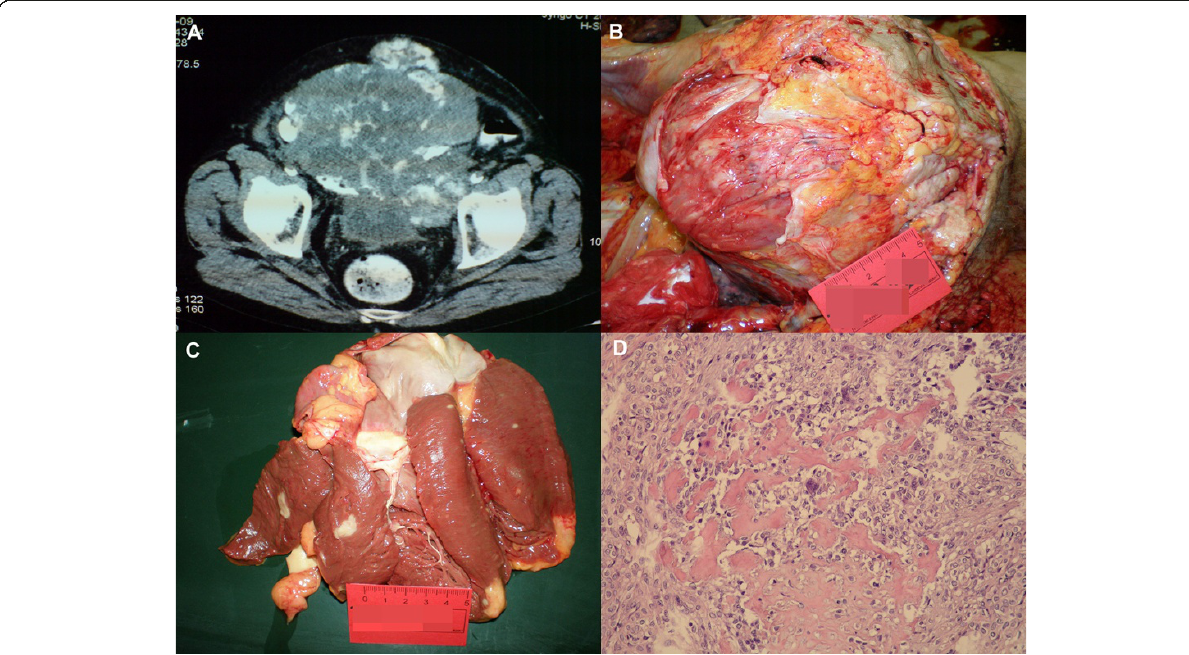
Figure 2 Radiographic and autopsy findings . A ) CT scan showing large intrapelvical tumor. B) The macroscopic view of the intrapelvical tumor at autopsy. C ) Metastatic nodules in myocardium. D ) Intrapelvical tumor found at autopsy histologically showed picture of osteosarcoma composed of atypical, oval to spindle cells, partly rimmed with osteoid. Multinuclear giant, osteoclast-like tumor cells were also visible (HE, ×